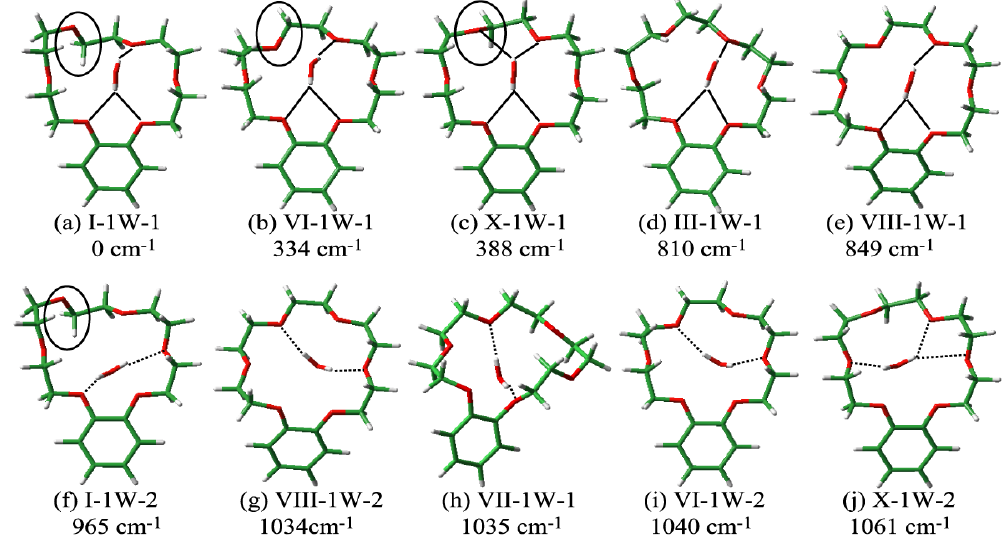
Figure 14. Optimized structures of B18C6-(H numbers shown in cm -1 represent the electronic energies of the isomers relative to that of the most stable isomer (I-1W-1). Solid and dotted lines denote H-bonding from the front and back sides of B18C6, respectively. Figure adapted from Reference